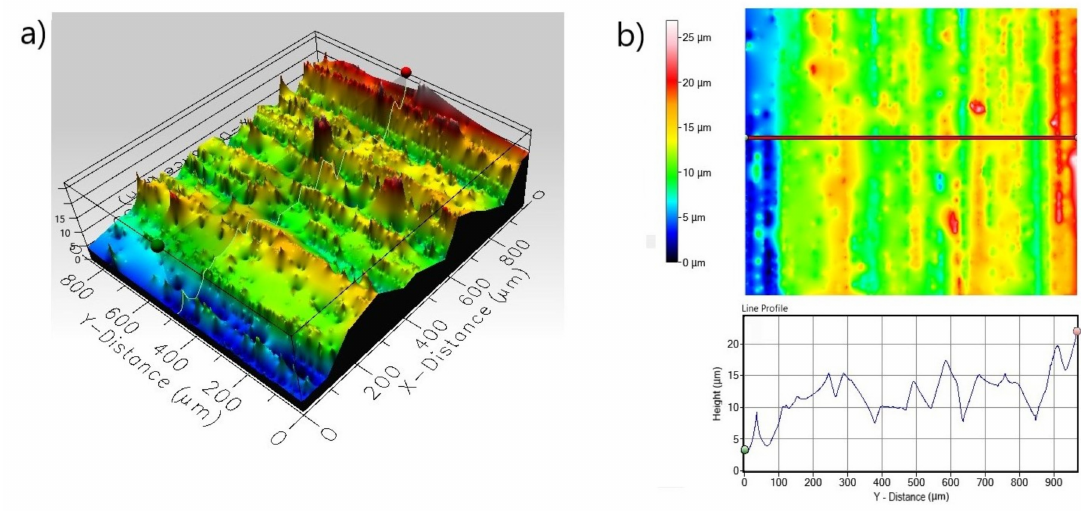
Figure 8. 3D profile ( a ) and 2D profile ( b ) of the corroded surface of non-borided Nickel 201 after the corrosion resistance test in a 3.5% NaCl solution.